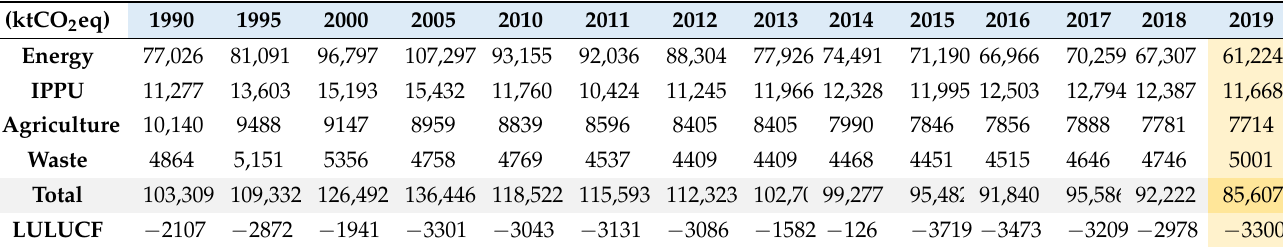
Table 4. GHG emissions by sector (UNFCCC